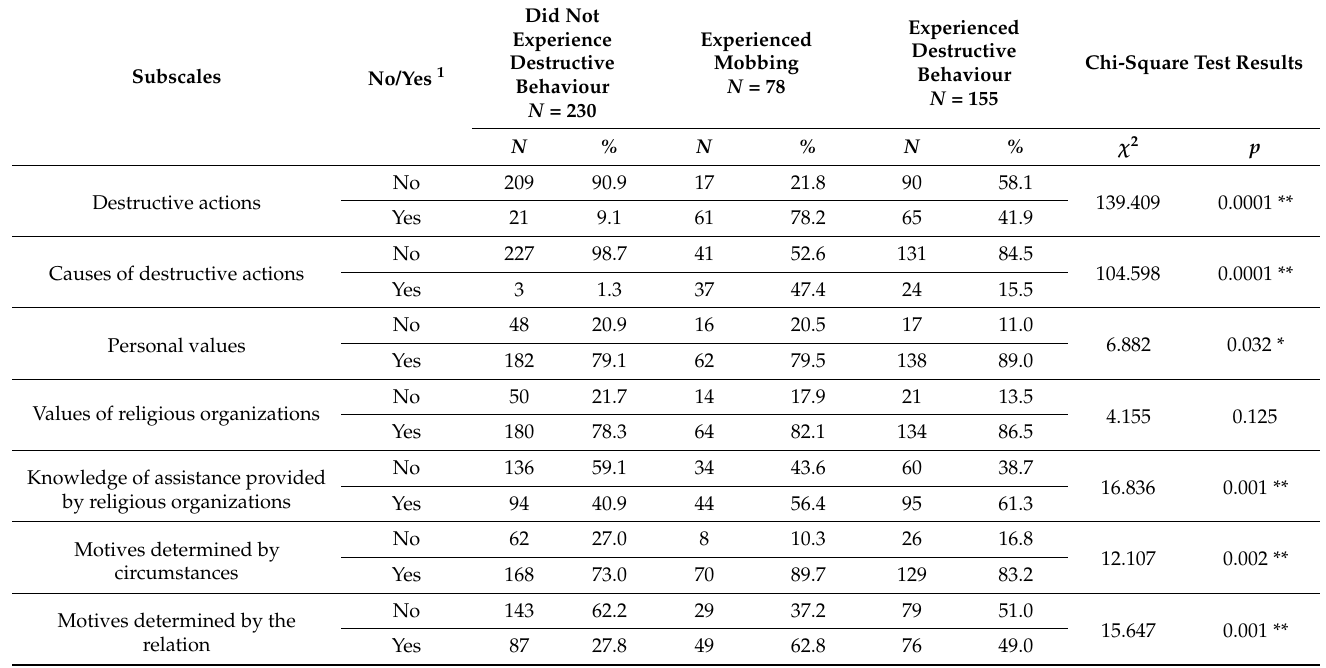
Table 5. The Chi-square test by different